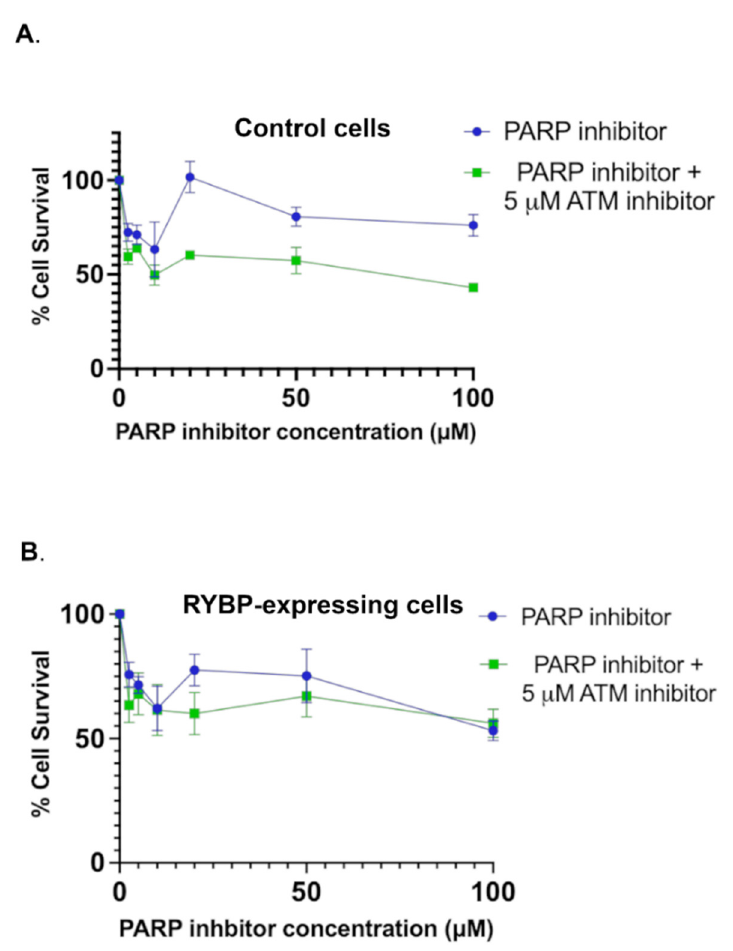
Figure 3. Effect of RYBP on the synergy between PARP inhibitor and ATM inhibitor. ( A ). In control U2OS cells, addition of ATM inhibitor (KU ‐ 55933) dramatically reduced the IC 50 of PARP inhibitor (ABT ‐ 888) from 220 μ M to 26 μ M. ( B ). In RYBP ‐ expressing cells, addition of ATM inhibitor (KU ‐ 55933) slightly reduced the IC 50 of PARP inhibitor (ABT ‐ 888) from 83 μ M.